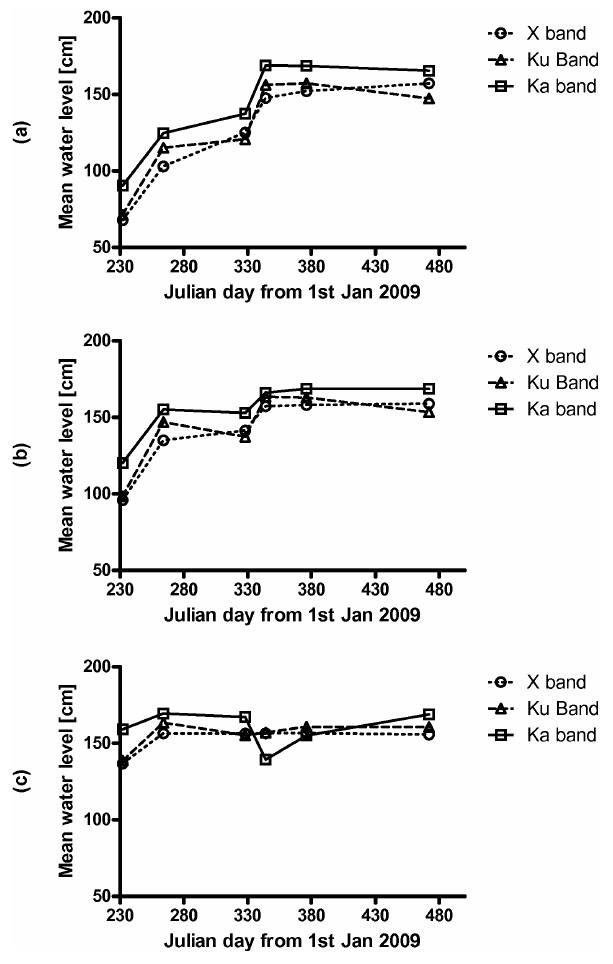
Fig. 11. Mean water level within the studied floodplain area as a function of time, estimated using ∆ T f values (Figure 10) and model simulations (Figure 6) for three different thresholds. (a) 1 dB, (b) 1.5 dB and (c) 2 dB